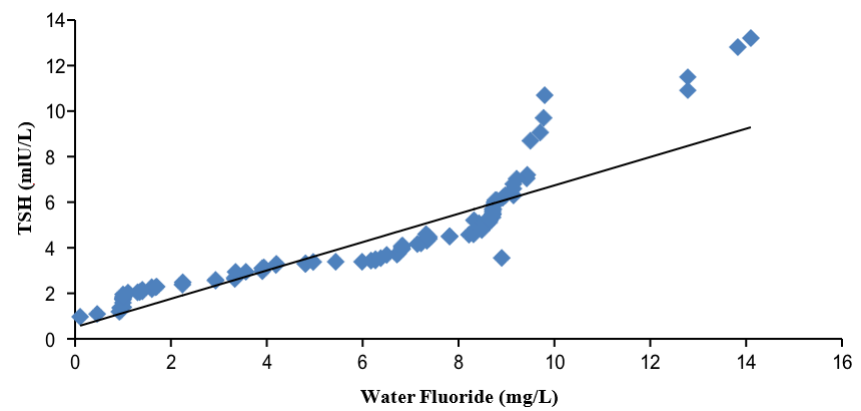
Figure 2: Scatter chart between WF and TSH of sample Group r = 0.90.